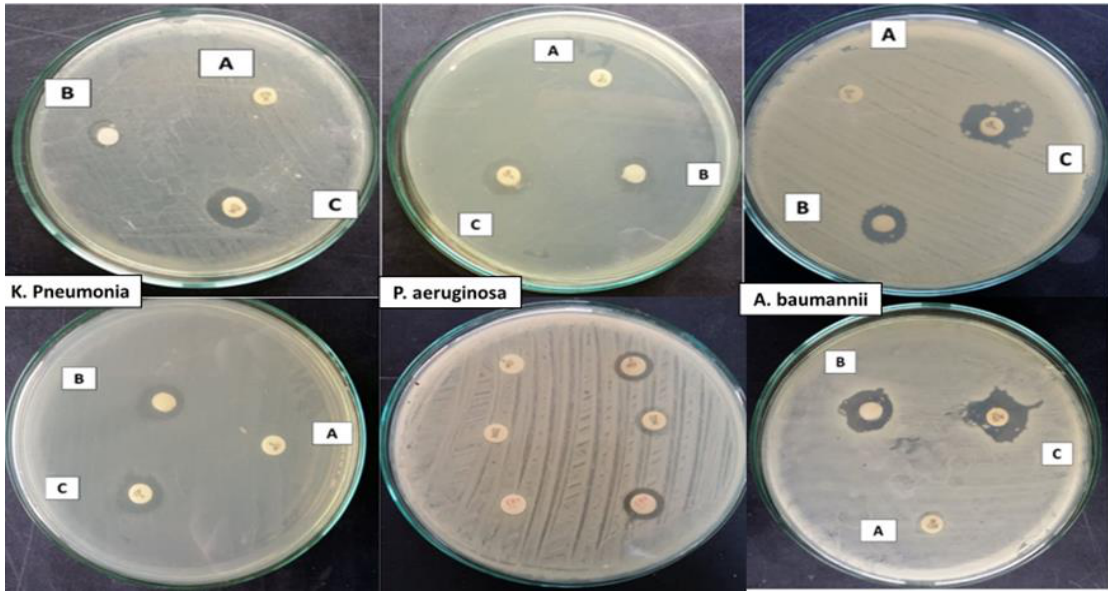
Figure 11. Effect of AgNPs on pathogenic bacteria Klebsiella pneumonia, Pseudomonas aeruginosa.